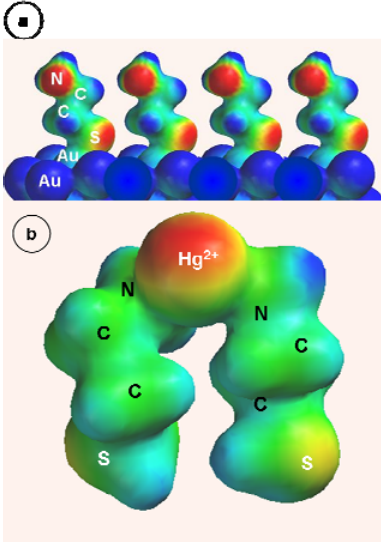
Figure 5. Molecular structure of a CA-SAM film on a Au piezoelectrode (a) and a surface complex (b) which can form in the course of Hg 2+ accumulation; Hg(CA) 2 structures calculated using HF method with 6-31G * basis set and pseudopotentials for Hg and Au